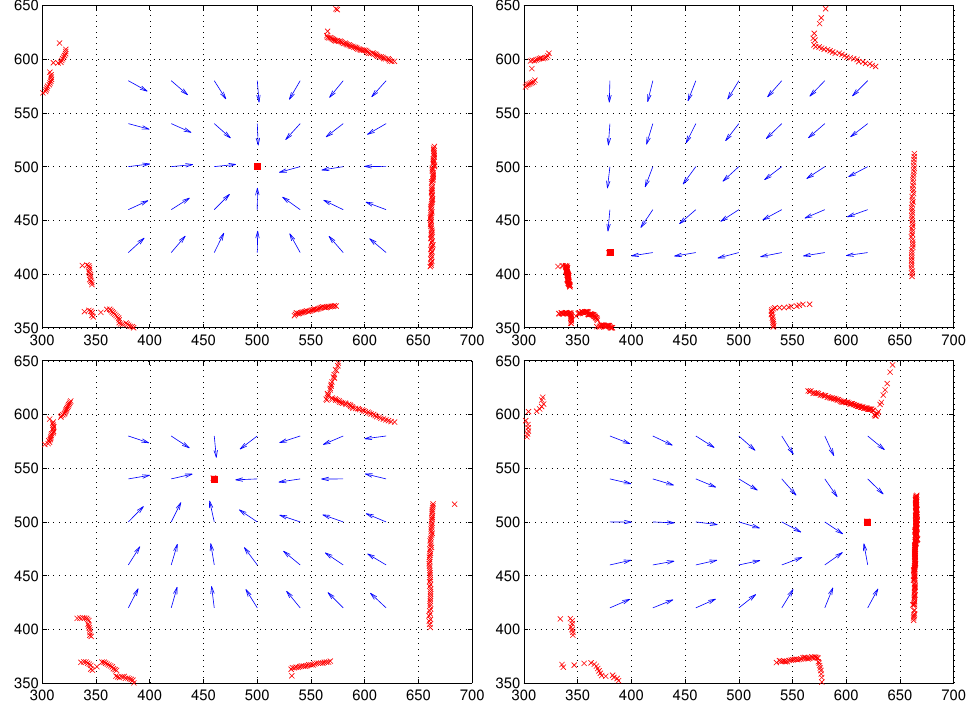
Figure 9. Homing performance with both range data and color intensity (reference compass available); the red box indicates the home position, and the arrows show the homing direction at each